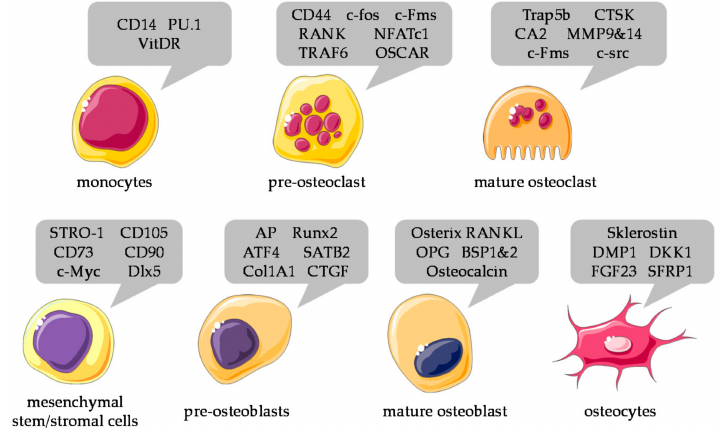
Figure 3. Numerous molecular markers can be detected in both osteoblast and osteoclast during differentiation; the figure above summarizes the most commonly used markers, including surface markers (vitamin D receptor (VitDR), osteoclast-associated receptor (OSCAR), STRO-1, or cluster of differentiation (CD)14, 44, 73, 90, 105)), cell specific proteins/enzymes (Trap5b, CTSK, CA2,